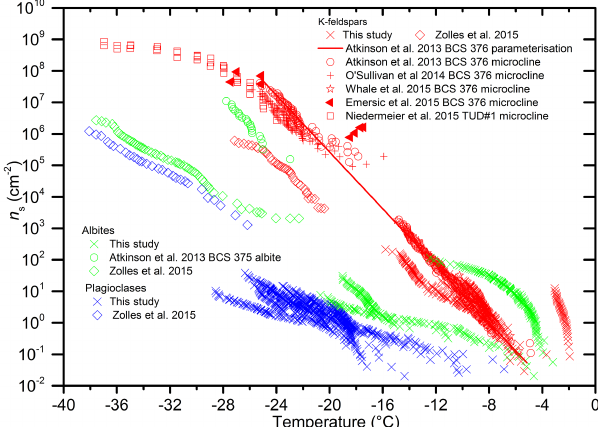
Figure 5. Comparison of literature data from Atkinson et al. (2013), Emersic et al. (2015), Niedermeier et al. (2015) and Zolles et al. (2015) with data from this study. Feldspars are coloured accord- ing to their composition, as in Fig. 3. 0.1wt% data for Amelia al- bite and LD1 microcline, which is not shown in Fig. 3, has been included. Where samples are known to lose activity with time the most active runs have been shown. Note that data from Niedermeier et al. (2015) include some data from Augustin-Bauditz et al.